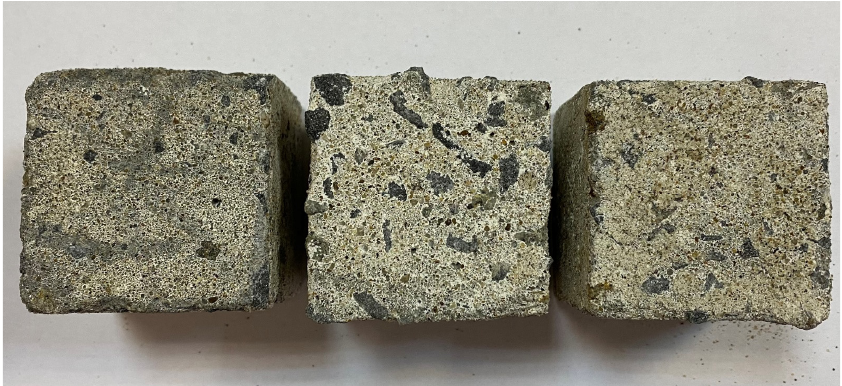
Figure 5. Photos of the main samples after 15 cycles of freezing and thawing: on the left—vibrated; in the center—centrifuged; on the right—vibrocentrifuged.